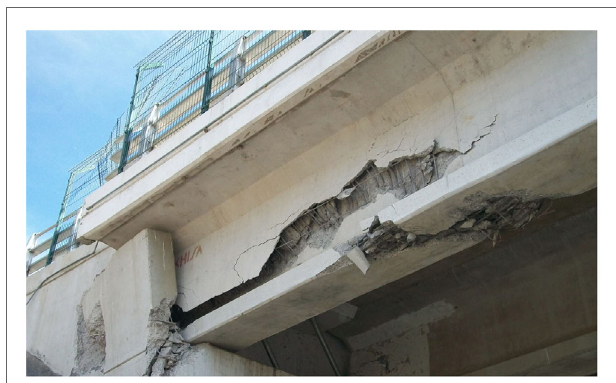
FigUre 1 | relative movement induced damage due to the 2010 chile earthquake